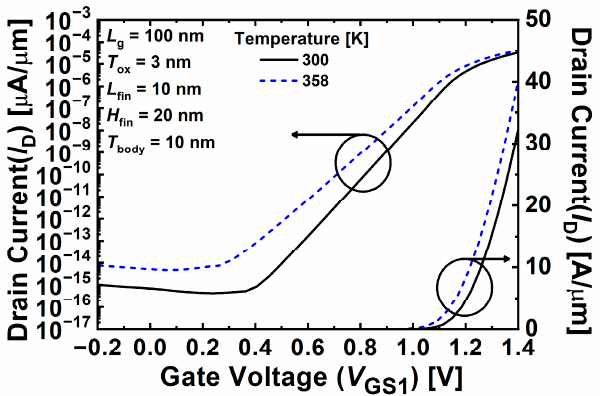
Figure 3. Transfer characteristics of proposed 1T-DRAM cell at different temperatures of 300 K and 358 K.